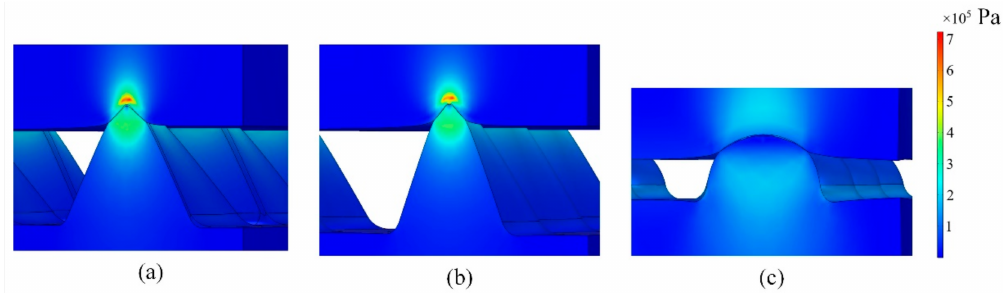
Figure 4. Von Mises stress of ( a ) pyramid, ( b ) cone and ( c ) hemisphere structures under 0.6 mm of displacement.